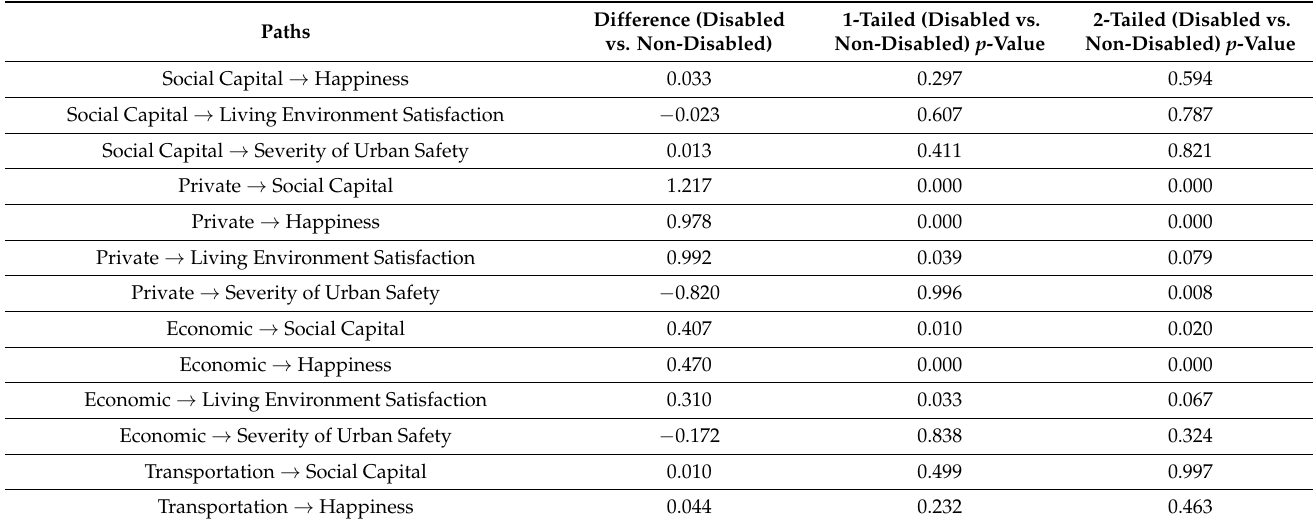
Table 8. Statistical difference test results in the path of the structural model between